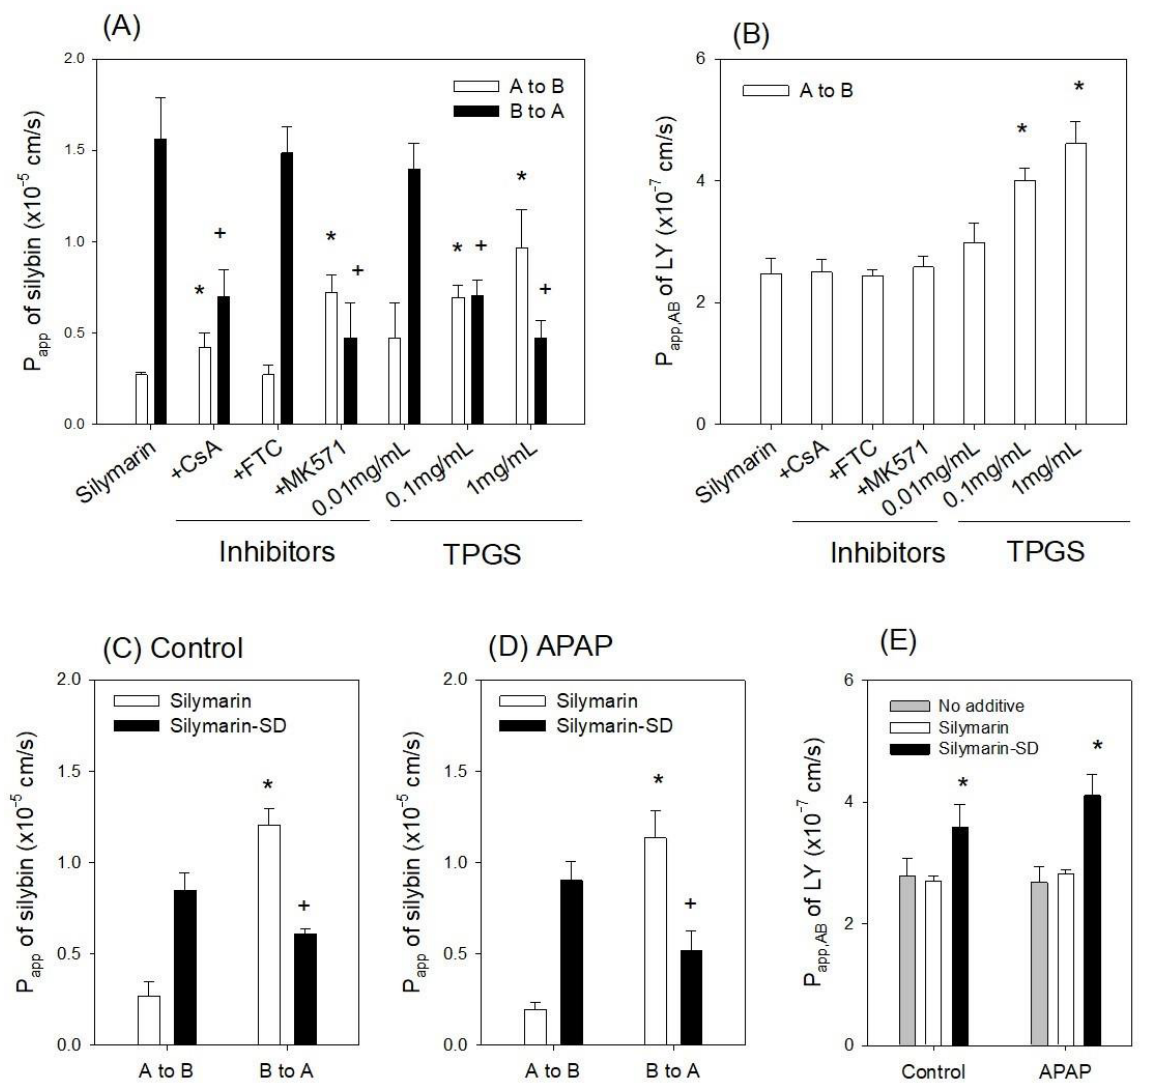
Figure 4. ( A ) The effect of efflux pump inhibitors and TPGS (0.01 mg/mL–1 mg/mL) on silybin permeability (P app ) in rat jejunal segments. Twenty micromole (20 µ M) cyclosporine A (CsA), 20 µ M fumitremorgin C (FTC), and 100 µ M MK-571 were used as inhibitors of P-gp, BCRP, and MRPs, respectively. ( B ) The effects of efflux pump inhibitors and TPGS (0.01 mg/mL–1 mg/mL) on A to B permeability (P app,AB ) of Lucifer yellow (LY) in rat jejunal segments. The P app of silybin in the presence of silymarin and silymarin-SD in jejunal segments from ( C ) control and ( D ) APAP-induced hepatotoxic rats. ( E ) The P app of LY in the presence of silymarin and silymarin-SD in jejunal segments of control and APAP-induced hepatotoxic rats. Each data point represents the mean ± standard deviation ( n = 4). * p < 0.05 compared with A to B P app